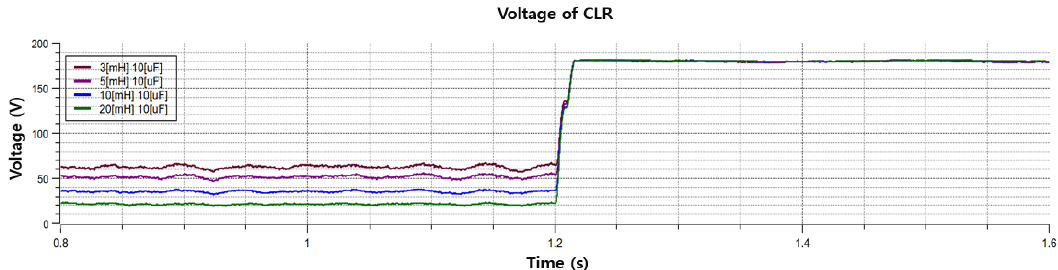
Figure 13. GPT zero-phase voltage (according to inductor capacity).